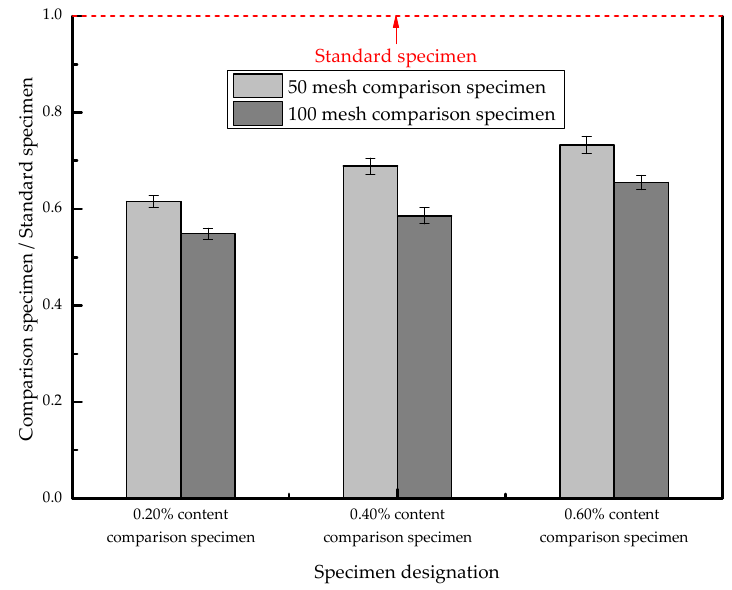
Figure 6. The normalized contrast map of penetration height.